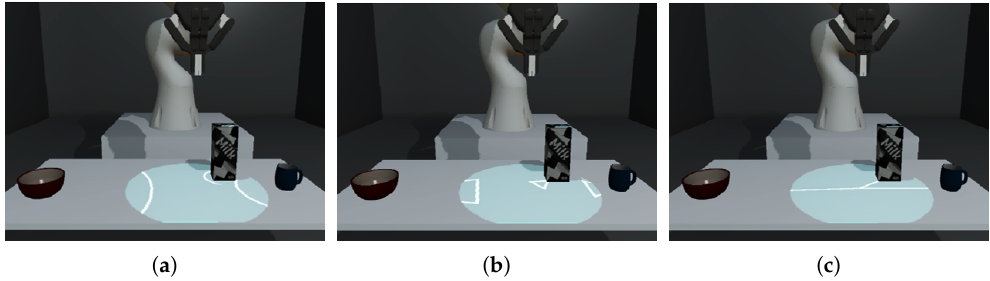
Figure 1. The compared visualization techniques to communicate the cobot’s perception are ( a ) Halo ; ( b ) Wedge ; and ( c ) Line